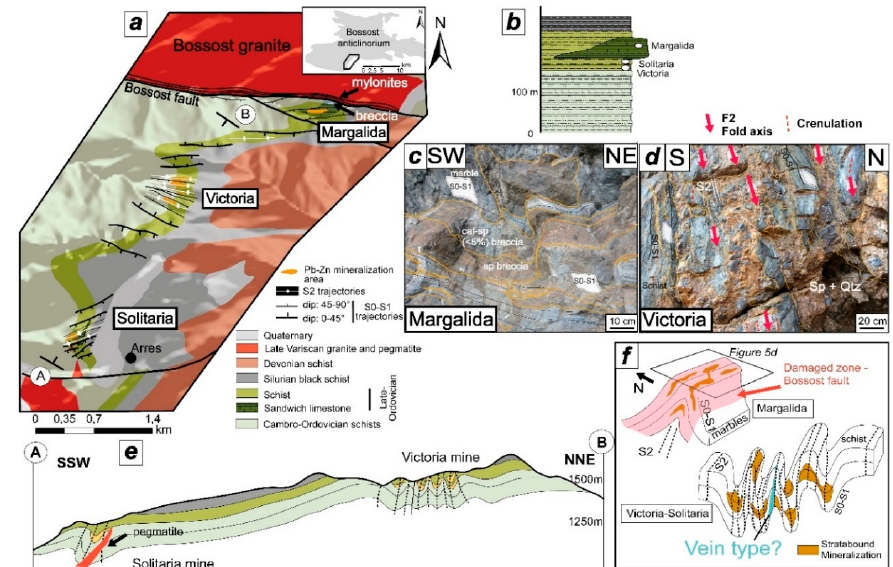
Figure 5. Margalida-Victoria-Solitaria district (see location on Figure 2a). ( a ) Structural map